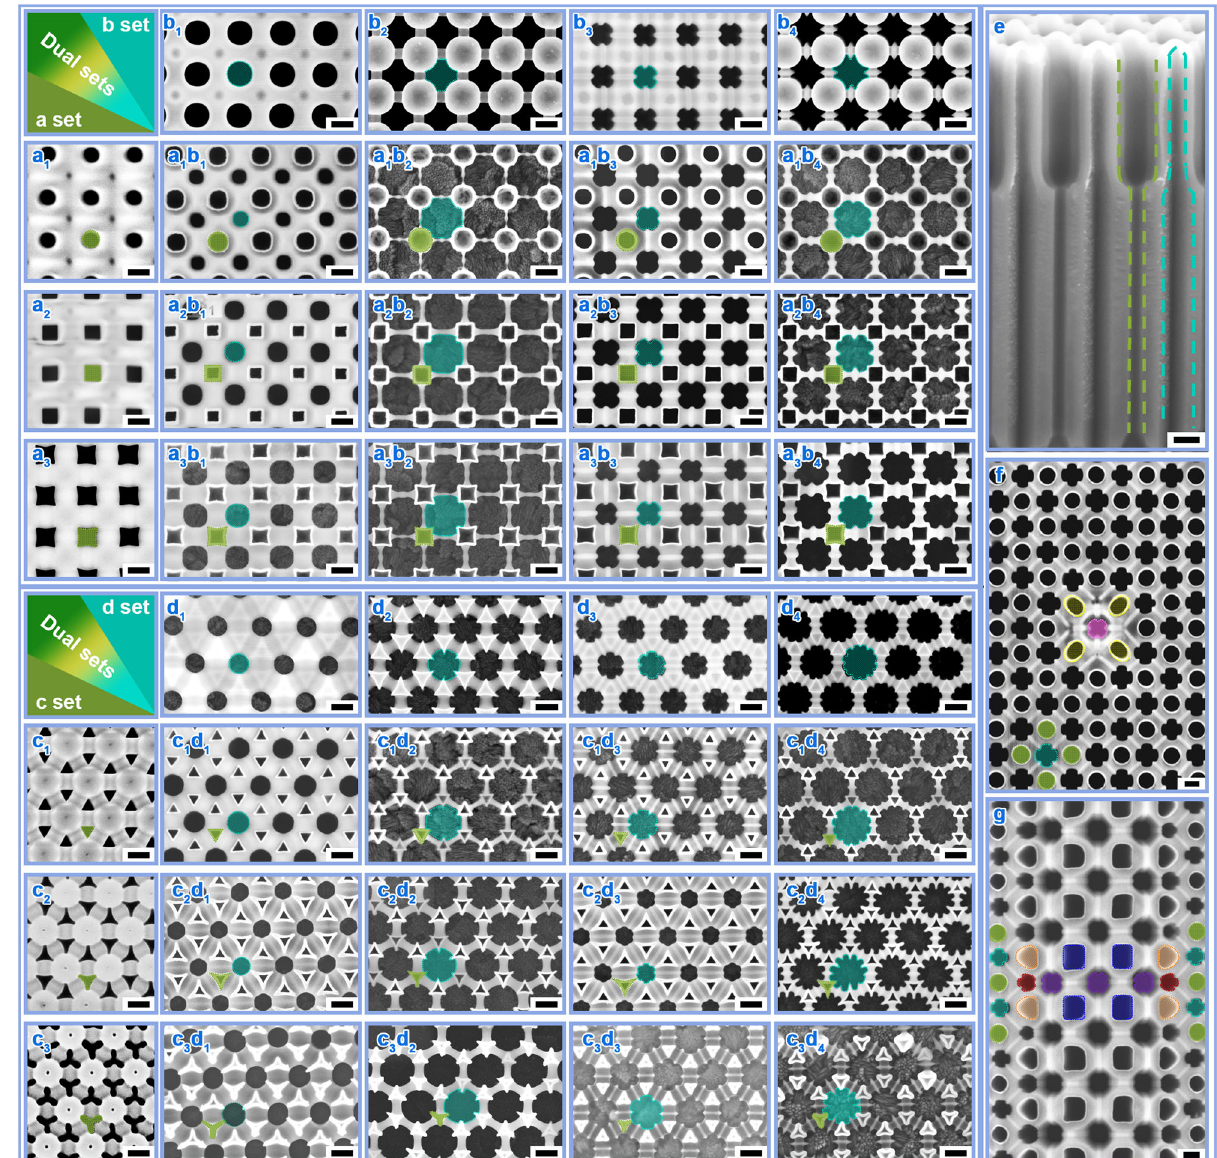
Fig. 5 Templates with shape-designable pore combinations. a i b j , Pore combinations, with the 1st-set pores (of tetragonal arrangement, green color) in a i (similar to the pores in Fig. 2b – d) and the 2nd-set pores (of tetragonal arrangement, cyan colors) in b j . The 1st-set and 2nd-set pores were formed before and after the wet-chemical etching procedure, respectively (please refer to Supplementary Fig. 28). The 2nd-set pores demonstrated four different shapes: when etching in NaOH solutions, the pores were isotropically enlarged from a circular shape (Fig. 5b 1 ) to a circular shape truncated with four voids (Fig. 5b 2 ); while using H 3 PO 4 solutions, the pores were selectively etched from a 4four-edged (Fig. 5b 3 ) to an eight-edged cross shape (Fig. 5b 4 ). c m d n , Pore combinations, with the 1st-set pores (of hexagonal arrangement, green color) in c m (similar to the pores in Fig. 2e – g) and the 2nd-set pores (of trigonal arrangements, cyan colors) in d n . The 2nd-set pores also demonstrate four shapes: a circular shape (Fig. 5d 1 ) and a circular shape with 6 voids (Fig. 5d 2 ) etched in NaOH solutions, as well as a six-edged cross shape (Fig. 5d 3 ) and a 12-edged cross shape (Fig. 5d 4 ) etched in H 3 PO 4 solutions. e , Pore combinations with two sets of out-of-plane dual- shape pores outlined by green (1st-set pore) and cyan (2nd-set pore) dashed lines. The anodization for growing the 1st-set pores was performed under sequential AVs of 140 → 200V. f , g Multi-shape pore combinations within spacing-different mixture arrangements, stemming from the tetragonal templates mixed with point (Fig. 4a) and area (Fig. 4e) units of long-spacing arrangements. Colors of green/yellow/orange/blue and colors of cyan/pink/purple/red indicate pores formed before and after the wet-chemical etching procedure, respectively. Scale bars: of pores can always be generated in a speci fi c con fi guration large-area uniformity as well (Supplementary Figs. 29, 30). Besides and reshaped into four shapes regardless of different-AV induced variation in oxide. By assembling the anodized 1st-set pores out-of-plane shape-designable pore combinations as well (Fig. 5e). (green) in Fig. 5a, c and the etched 2nd-set pores (cyan) in Fig. 5b, The out-of-plane shape designability of the 2nd-set pores (out- d into one matrix, we have achieved 2 × 3 × 4 pore shape com- lined by cyan dashed line) arises from the fact that the pore walls binations, as summarized in Fig. 5a i b j ( i = 1 – 3, j = 1 – 4) and formed at different AVs have inhomogeneous composition and thus etching rates (Supplementary Fig. 31) 22 . Fig. 5c m d n ( m = 1 – 3, n = 1 – 4). These pore combinations exhibit